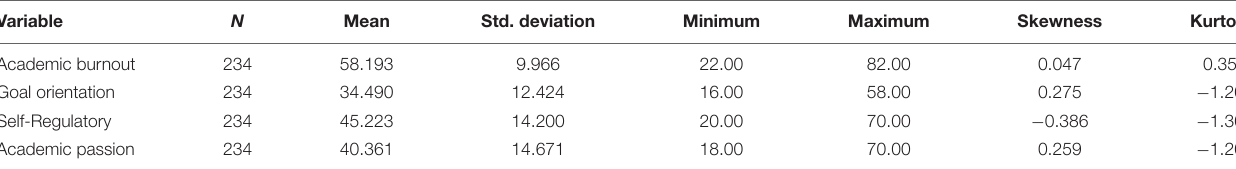
TABLE 2 | Central indicators and dispersion of research variables.